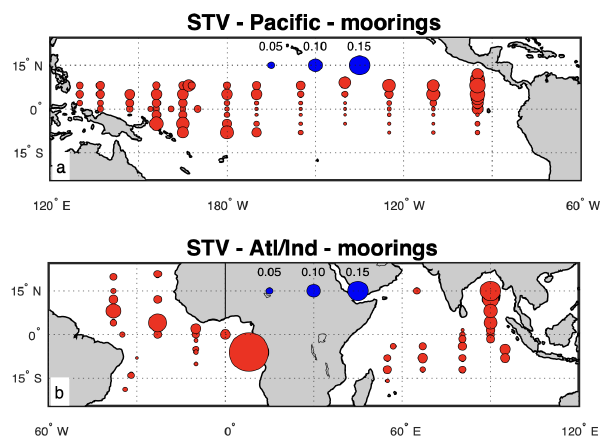
Figure 4. Median STV for each mooring for the (a) Pacific Basin and (a) Atlantic and Indian basins. The sizes of the circles indicate the magnitude of the STV, with the scale shown as blue circles near the middle of each panel.